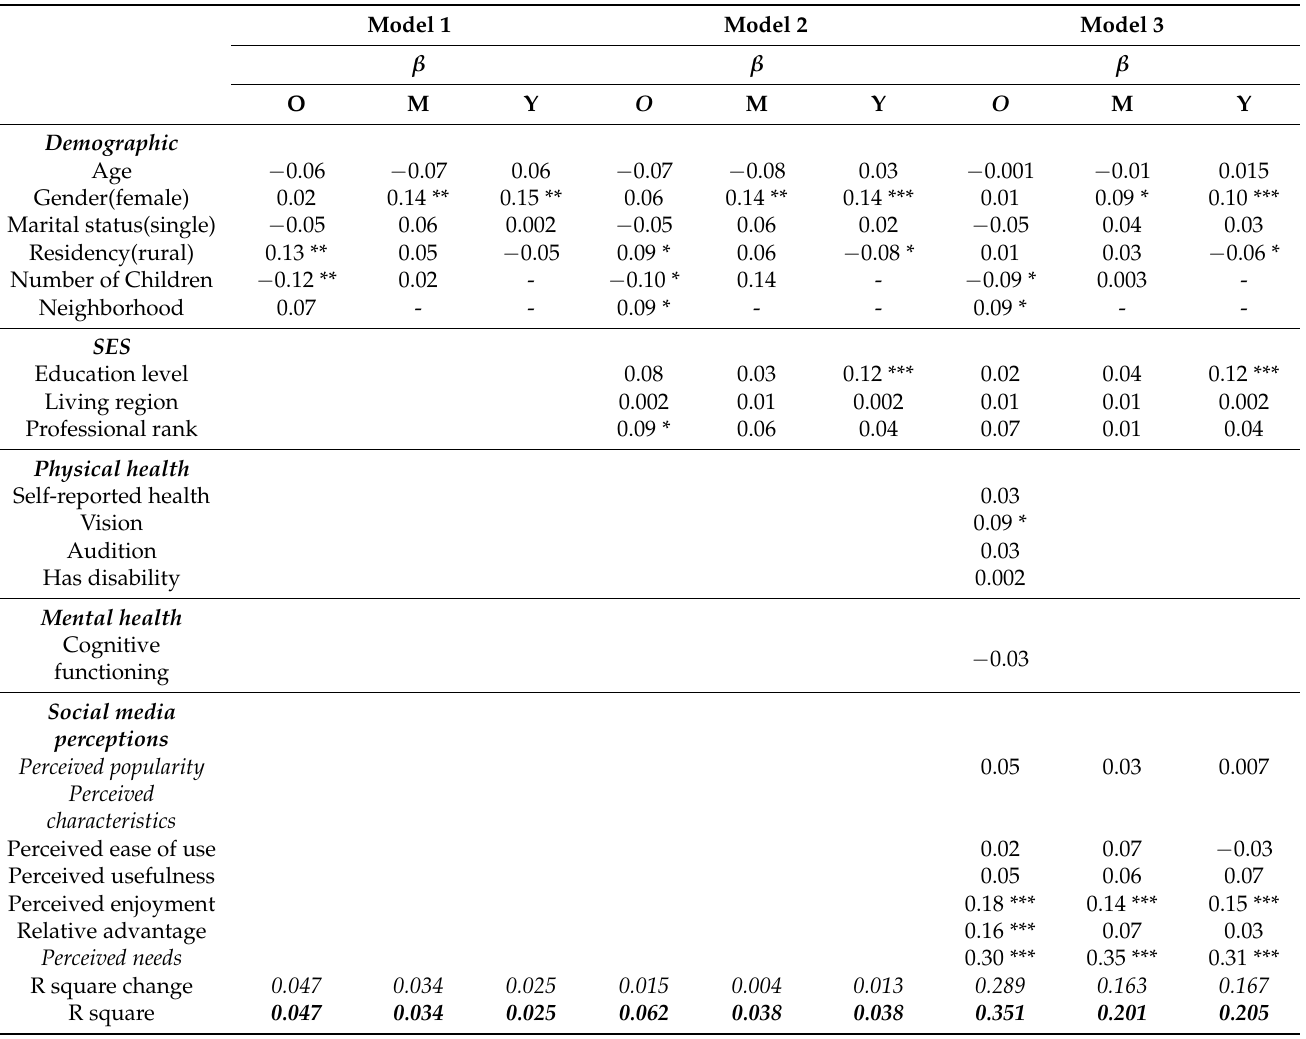
Table 4. Hierarchical linear regression of the intensity of social media engagement. Model